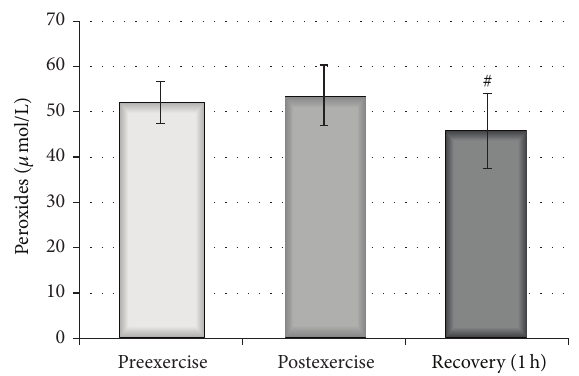
Figure 6: Effect of physical exercise on peroxide concentration in plasma measured before, after, and 1 hour after physical exercise. # indicates significant difference between postexercise and 1h recov- ery ( 𝑃 < 0.02 ).